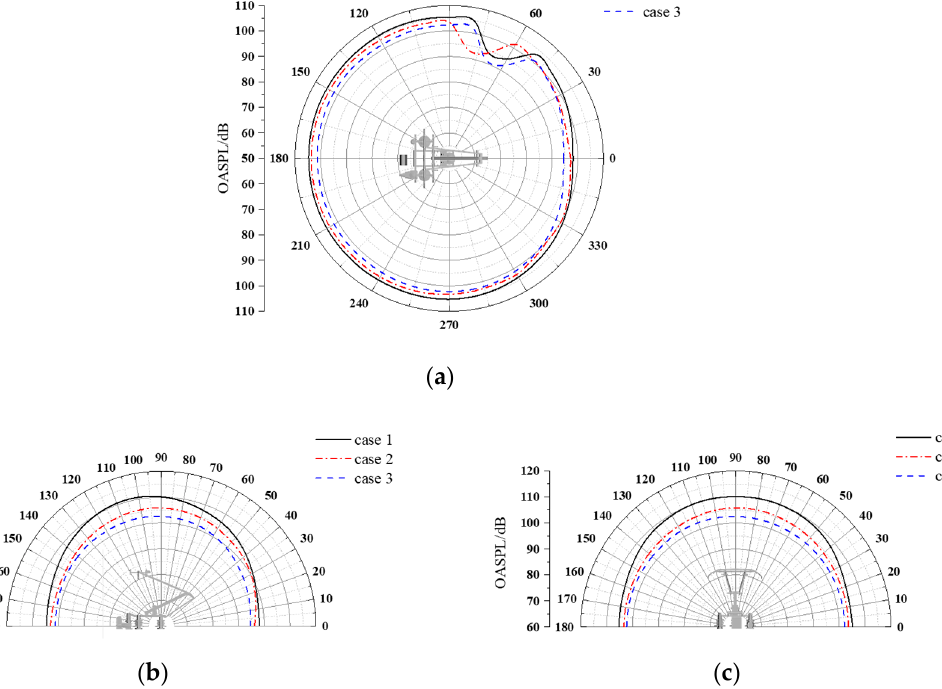
Figure 16. Aerodynamic noise directivity caused by pantograph in different planes. ( a ) X-Y plane; ( b ) X-Z plane; ( c ) Y-Z plane.